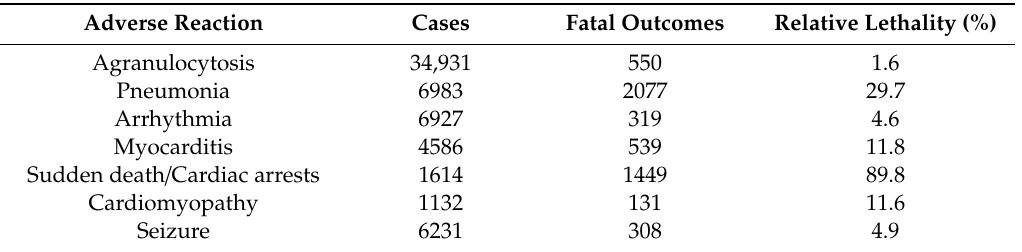
Table 1. Summary of the major adverse reactions in the blood, lung, heart, and brain associated with clozapine (CLZ) of reported cases, fetal outcomes and relative lethality rate (%) in the World Health Organization’s global database (VigiBase)